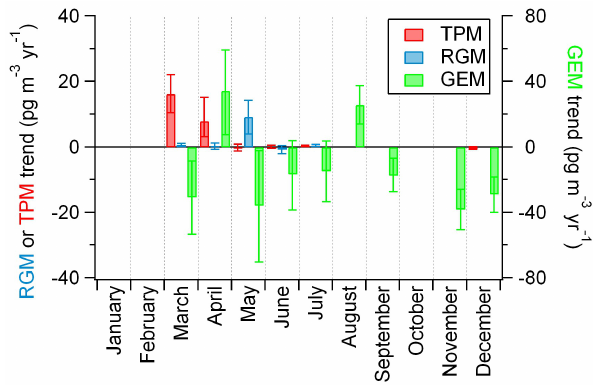
Fig. 5. Time series of reactive gaseous mercury (RGM) and partic- ulate mercury (TPM) at Alert.